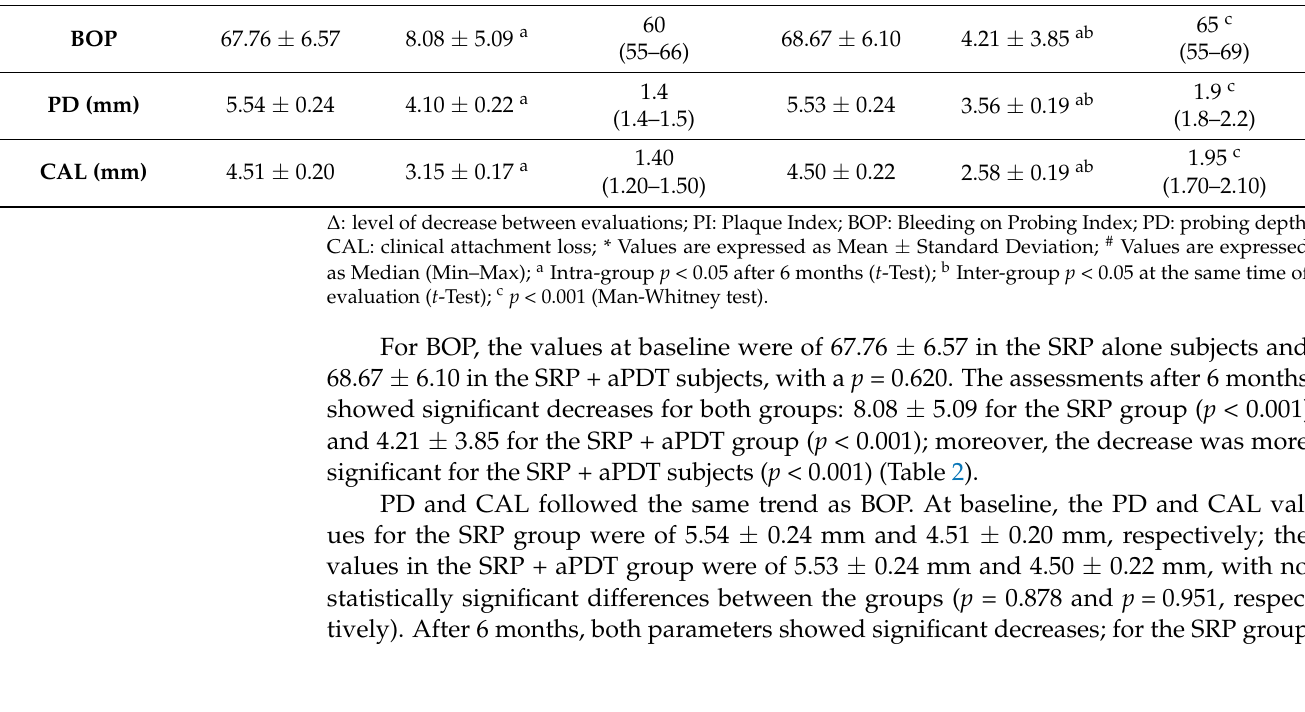
Table 2. Clinical parameters for study groups at baseline and after 6 months.